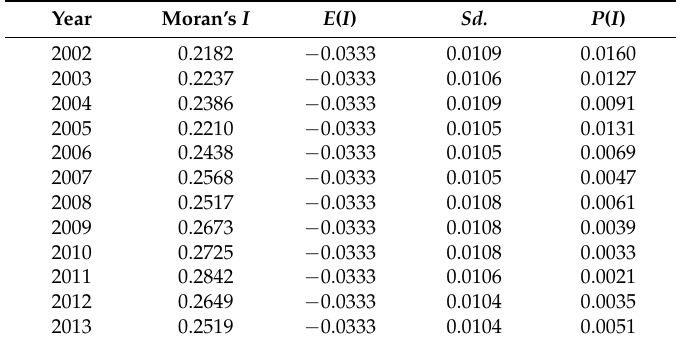
Table 1. Global Moran’s I test of wastewater discharge in China, 2002–2013.